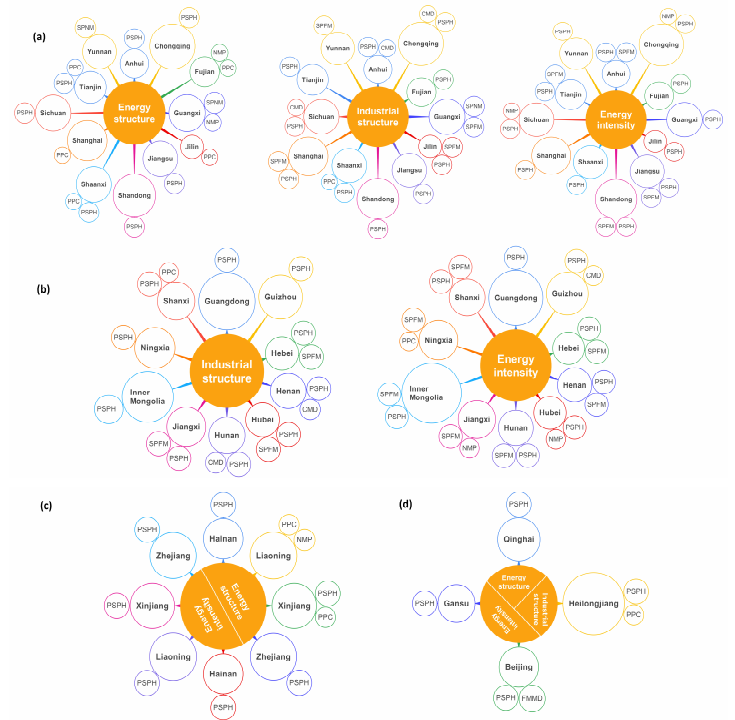
Figure 3. Key industrial sectors for CO 2 mitigation in each region. ( a ) Group 1 (the inhibitive